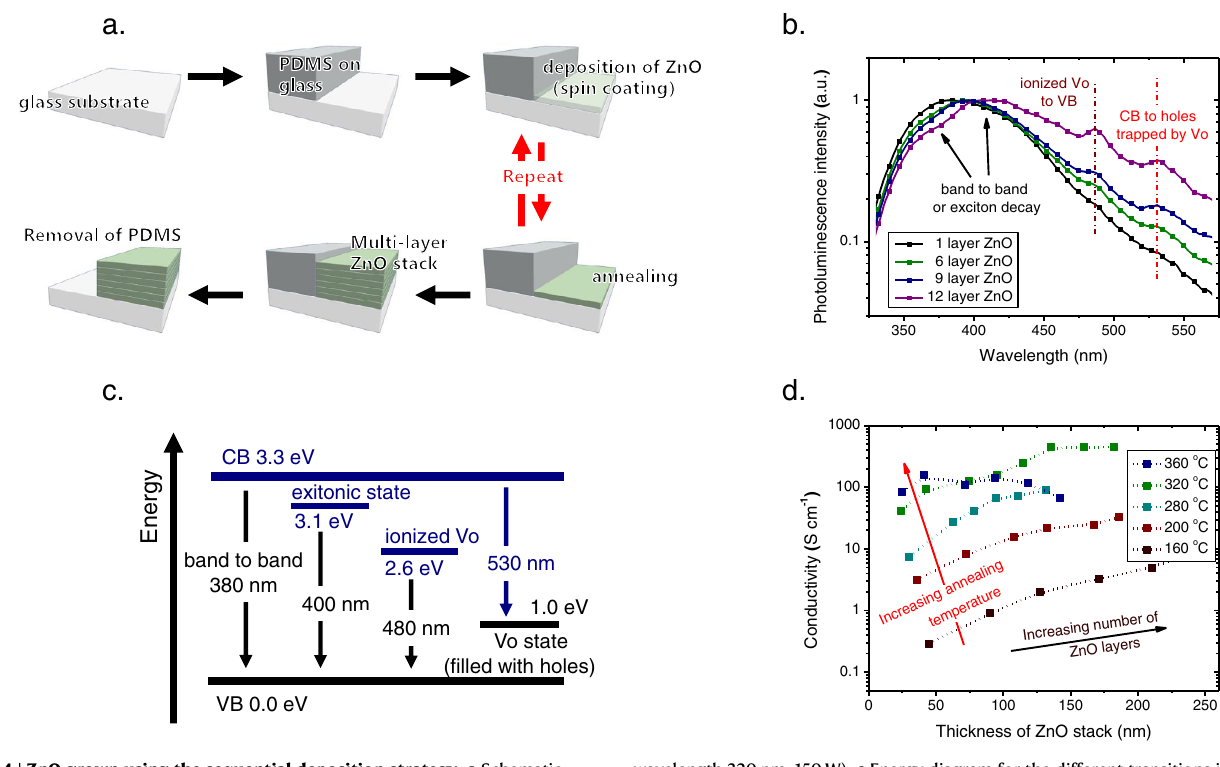
wavelength 320nm, 150W). c Energy diagram for the different transitions in the ZnO stack, identi fi ed by the PL measurements. d Conductivity of the ZnO stacks with different numbers of ZnO layers, annealed with different temperatures, measured after UV treatment. The deposition and annealing of the wet ZnO fi lms are done in a controlled environment with relative humidity being